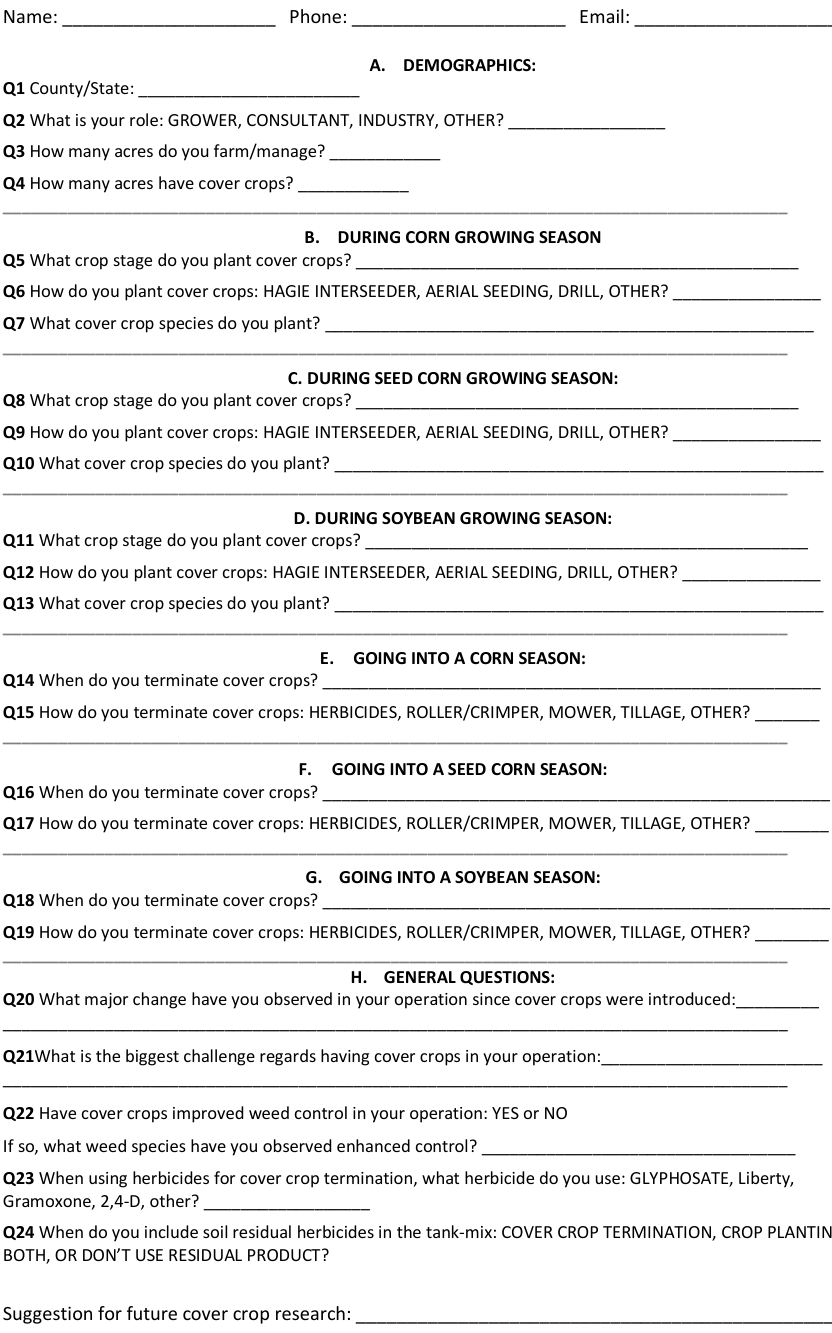
Figure 1. The survey questionnaire conducted with 82 individuals during the 2017 Cover Crops Conference (14 February 2017) held at the Eastern Nebraska Research and Extension Center, Ithaca,